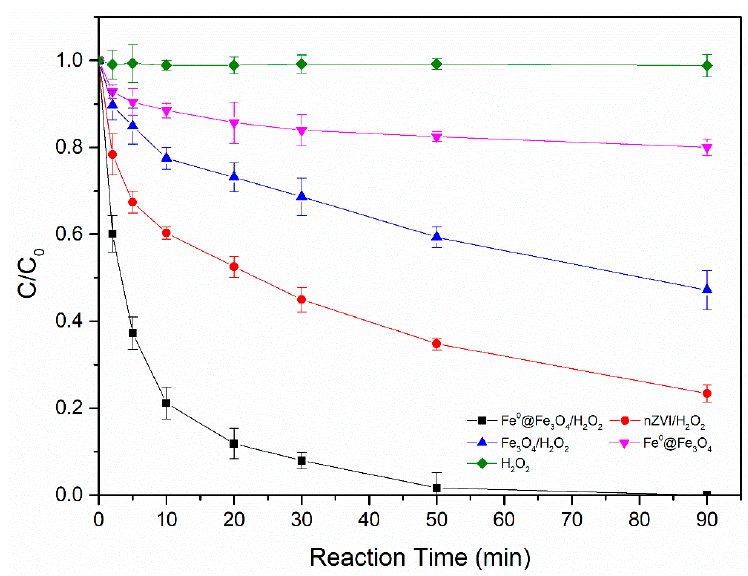
Figure 7. Comparison between different catalysts for the degradation of 2,4-D ([2,4-D] 0 = 5.0 mg/L, [catalyst] 0 = 0.5 g/L, H 2 O 2 = 1 mM, pH = 5.0 ± 0.2, T = 30 °C).